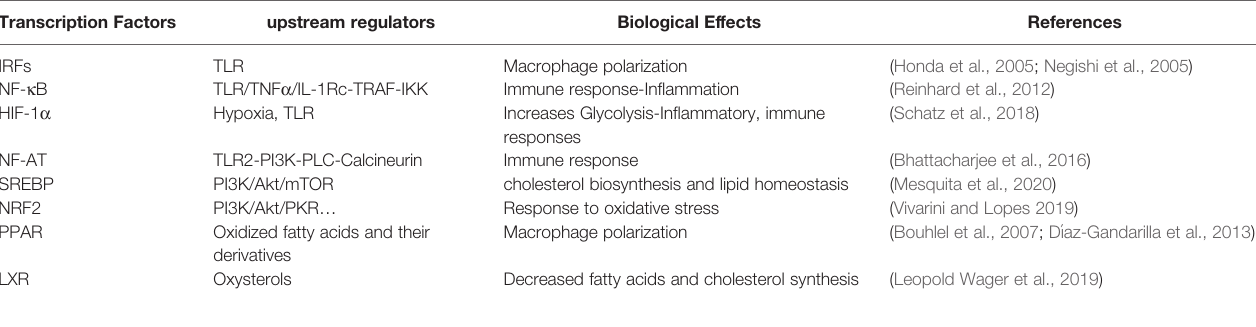
TABLE 1 | Key transcription factors that modulate macrophages response to Leishmania